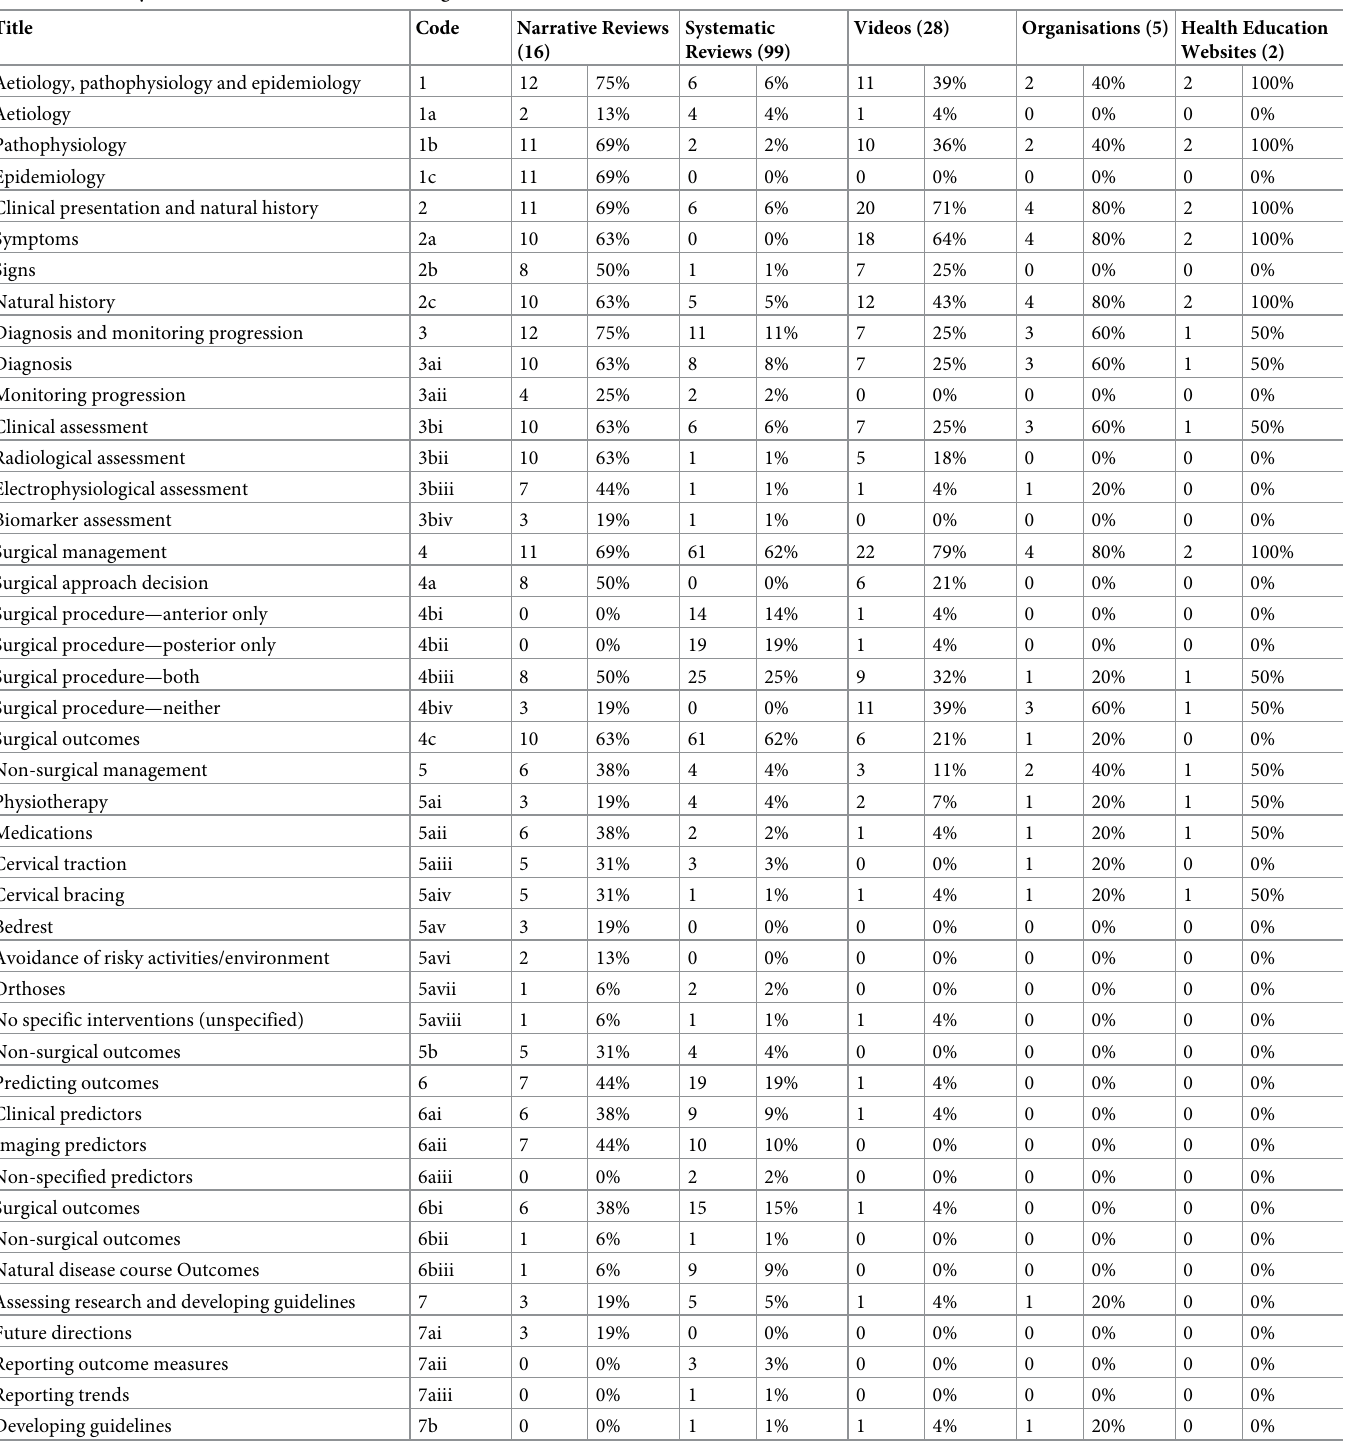
Table 4. Summary of DCM educational resources